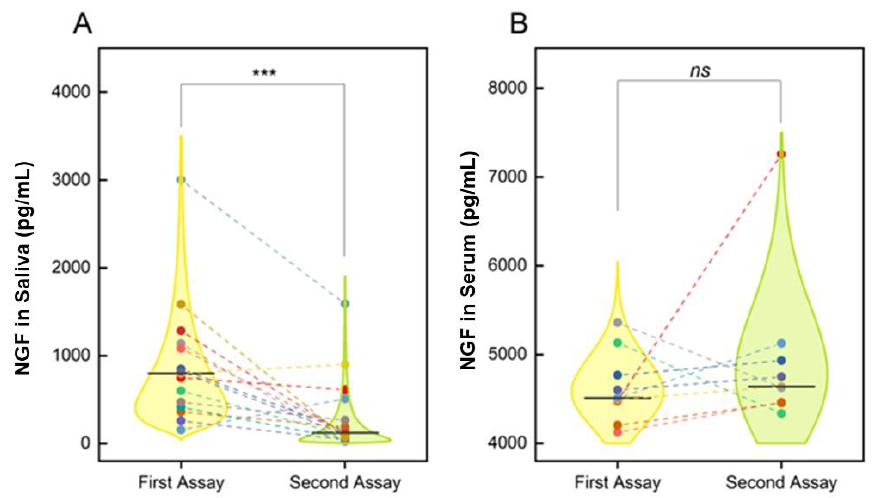
Figure 1. NGF changes. ( A , B ) Violin plot analyses for the comparison of the NGF levels in the SARS- CoV-2 acute phase and the follow-up measurement (6 months after the acute phase) in saliva ( A ) and serum ( B ) samples. Data distribution is visualized using the log-normal distribution that best fits the data. Different subjects are highlighted in different colors (dots), and paired measures are connected with dashed lines. Median values are reported as continuous horizontal lines. Non-parametric paired Wilcoxon Signed Rank Test. ***, p < 0.001.